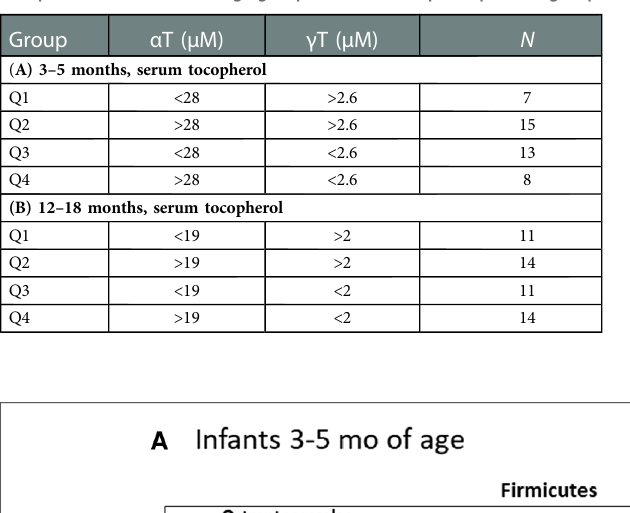
TABLE 1 Grouping of infants by median serum α T and γ T concentrations in the INHANCE cohort. Serum α T and γ T for infants in the INHANCE cohort were measured by HPLC. Median serum α T and γ T concentrations for infants at ( A ) 3 – 5 months and ( B ) 12 – 18 months of life. Four groups Q1, Q2, Q3, and Q4 of infants for 3 – 5 months and for 12 – 18 months infants were generated using high and low α T and γ T concentrations de fi ned as higher or lower than the median for the tocopherol isoform for the age group. N , number of participants in group.